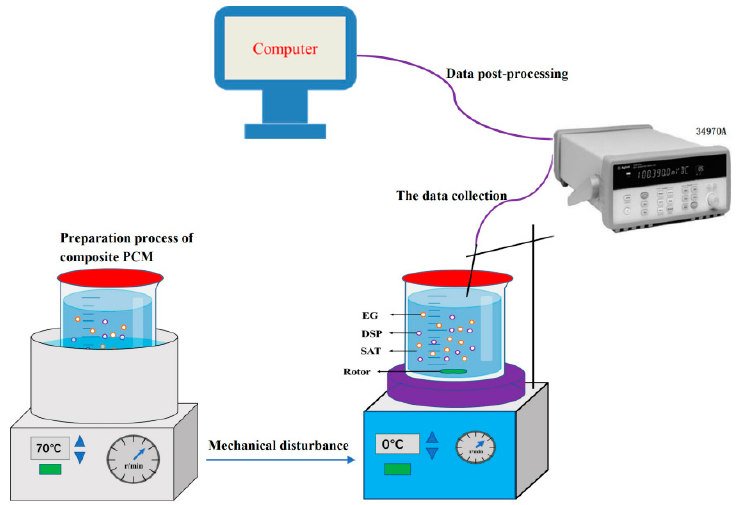
Figure 1. The experimental flow chart of the preparation of CPCM.